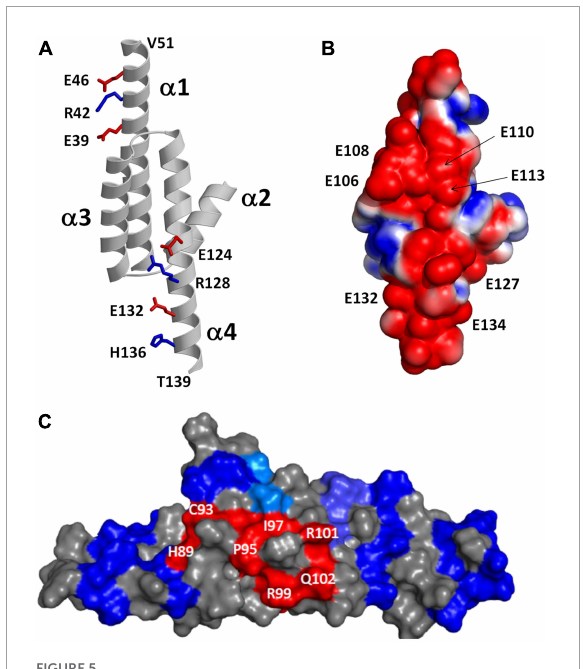
FIGURE5 Structural analysis of RD3. Adapted from Peshenko et al. (2019). (A) Main chain structure of RD3. Salt bridges near the N-terminus (E39, R42, and E46) and C-terminus (E124, R128, E132, and H136) rigidify α 1 and α 4 to form an elongated 4-helix bundle. (B) Map of surface electrostatic potential of RD3 illustrates negatively charged protein surface (red). (C) Space-filling representation of RD3 shows residues on the protein surface (highlighted in red) that contact RetGC1.